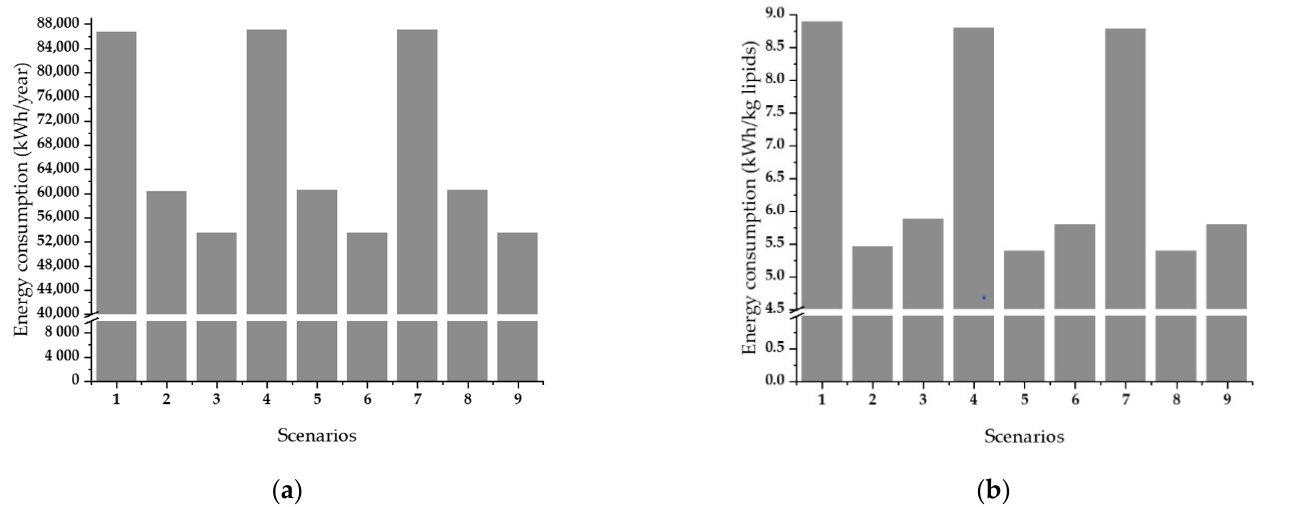
Figure 5. Energy consumption in the scenarios analyzed for lipid production: ( a ) Total energy consumption per year; ( b ) total energy consumption per kg of lipids produced.